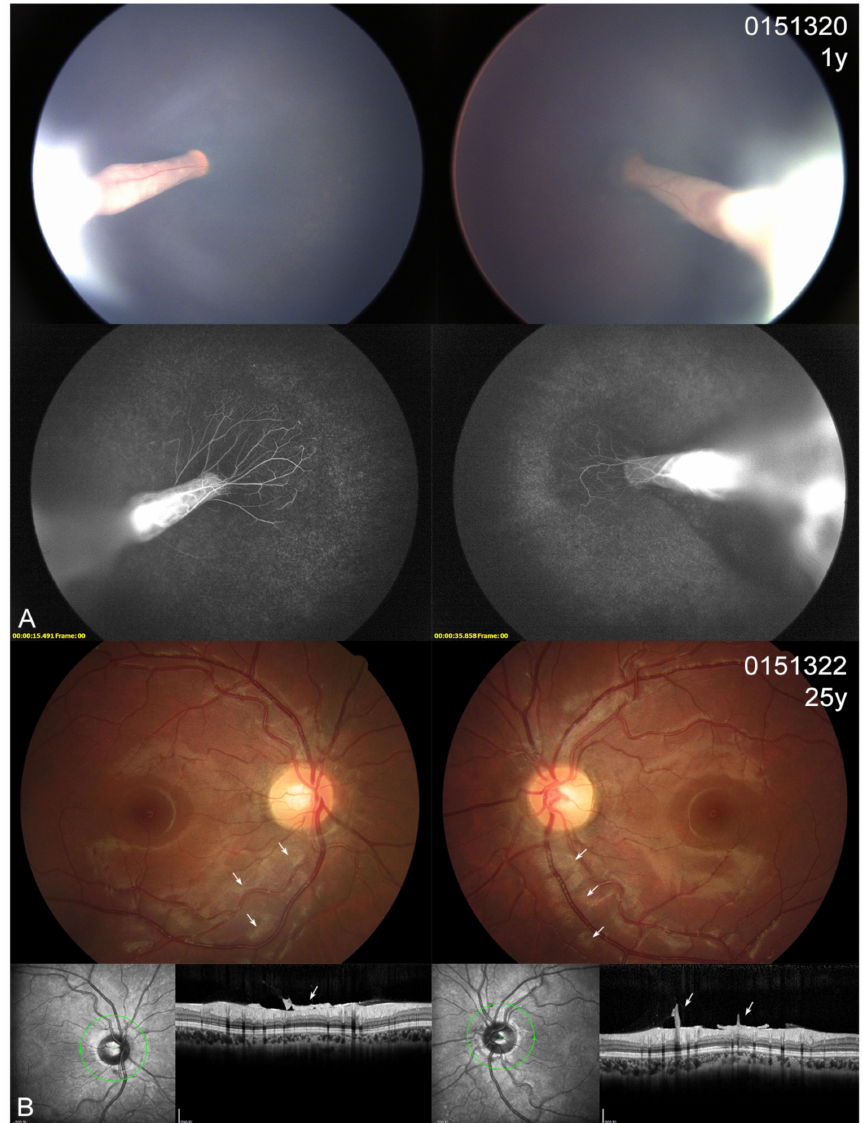
Figure 6. Color fundus (CF), fluorescein angiography (FA) photographs and OCT scans from a family with the variant c.299C>T. ( A ) The CF and FA images of proband 0151230 show bilateral retinal folds and tractional retinal detachments. ( B ) CF photographs and OCT scans of mother 0151322 display tortuous vessels and a thicker posterior hyaloidal matrix (white